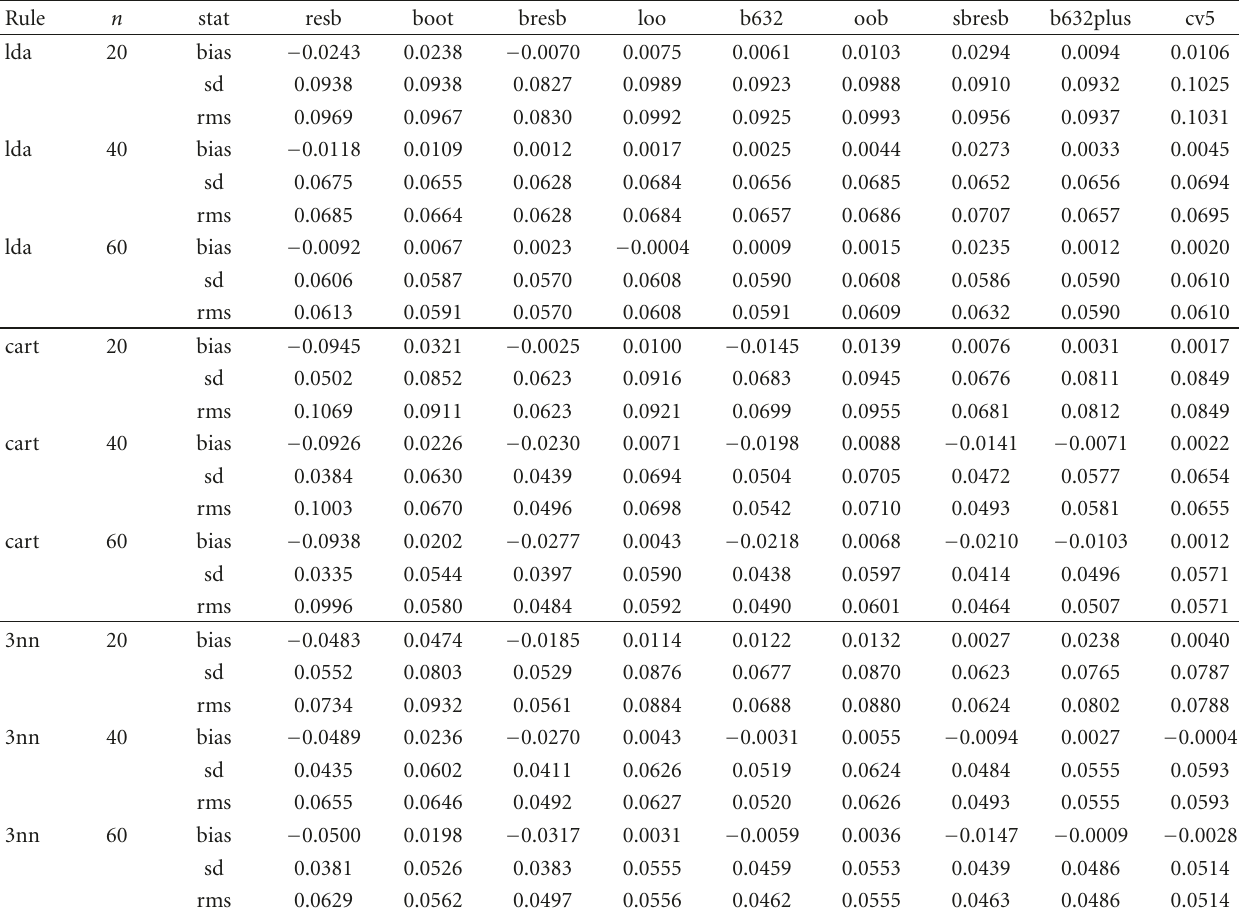
Table 2: Bias, variance (standard deviation), and RMS for di ff erent error estimators, with di ff erent base classification rules, for lung cancer gene expression data, and dimensionality p =